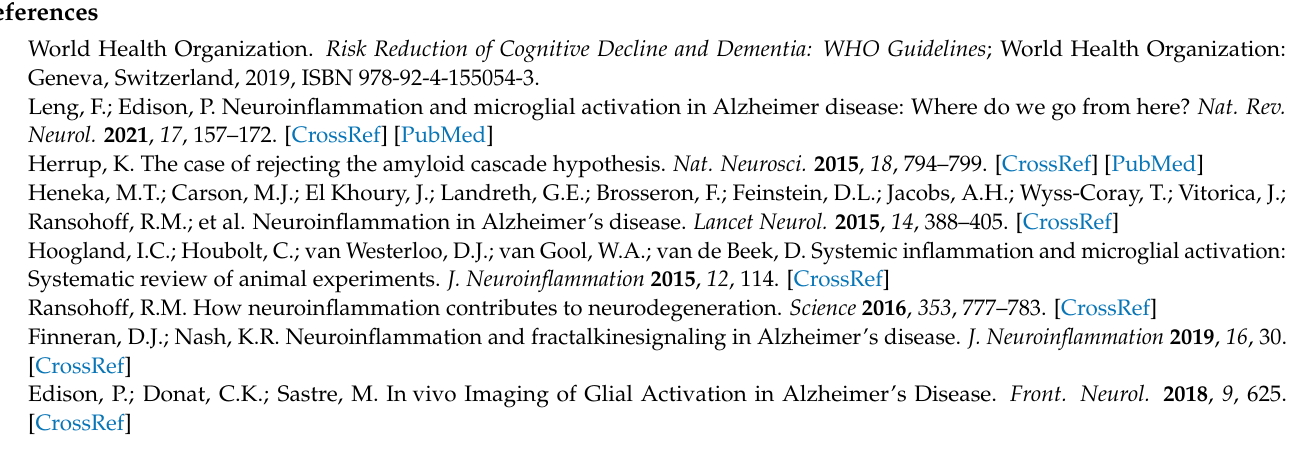
Group A, divided into Group A’ and Group A”, and Group B. Figure S6—CX3CL1 values in single subjects belonging to Group A and Group